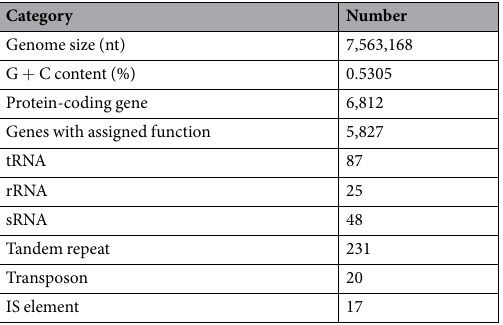
Table 1. General features of Paenibacillus sp. SSG-1